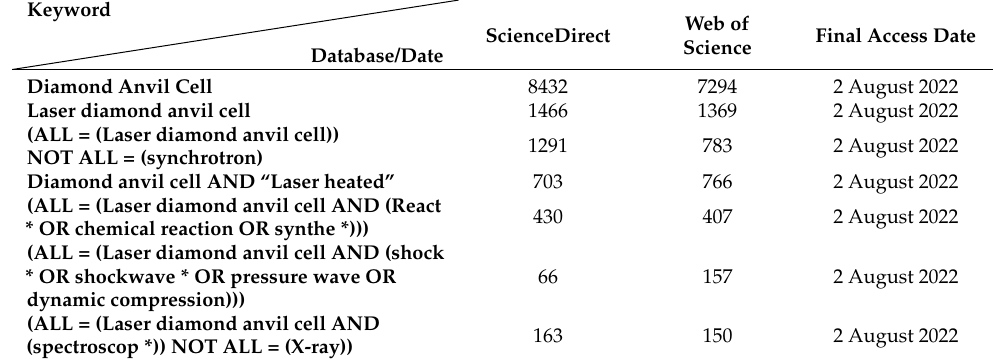
Table A1. Summary of all research papers that result from the key search words in two